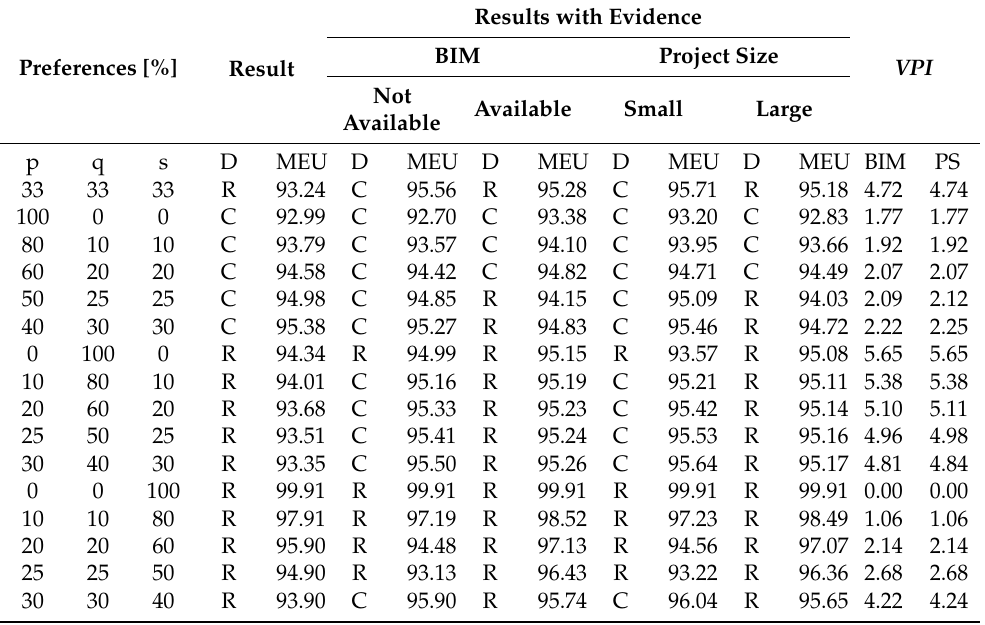
Table 6. Variation of results due to user interaction (R = collaborative robot, C = conventional